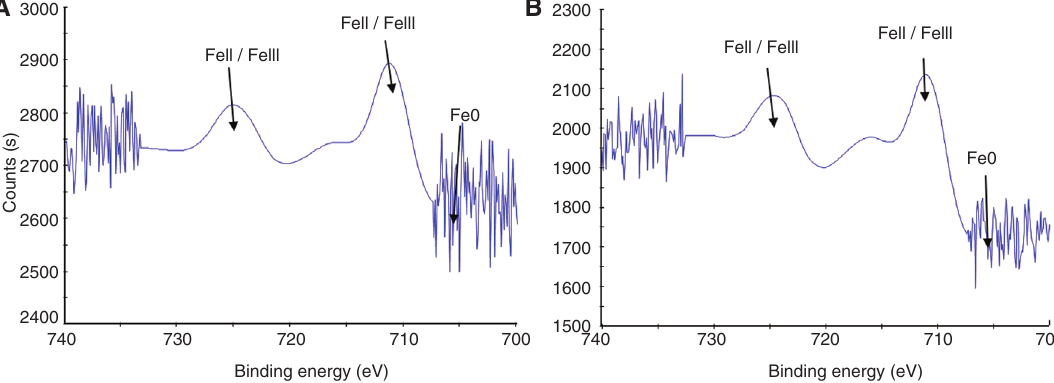
Figure 3 X-ray photoelectron spectroscopy (XPS) survey on Fe 2p3 / 2 of ‘green’ (A) TEA-Fe and (B) CAF-Fe